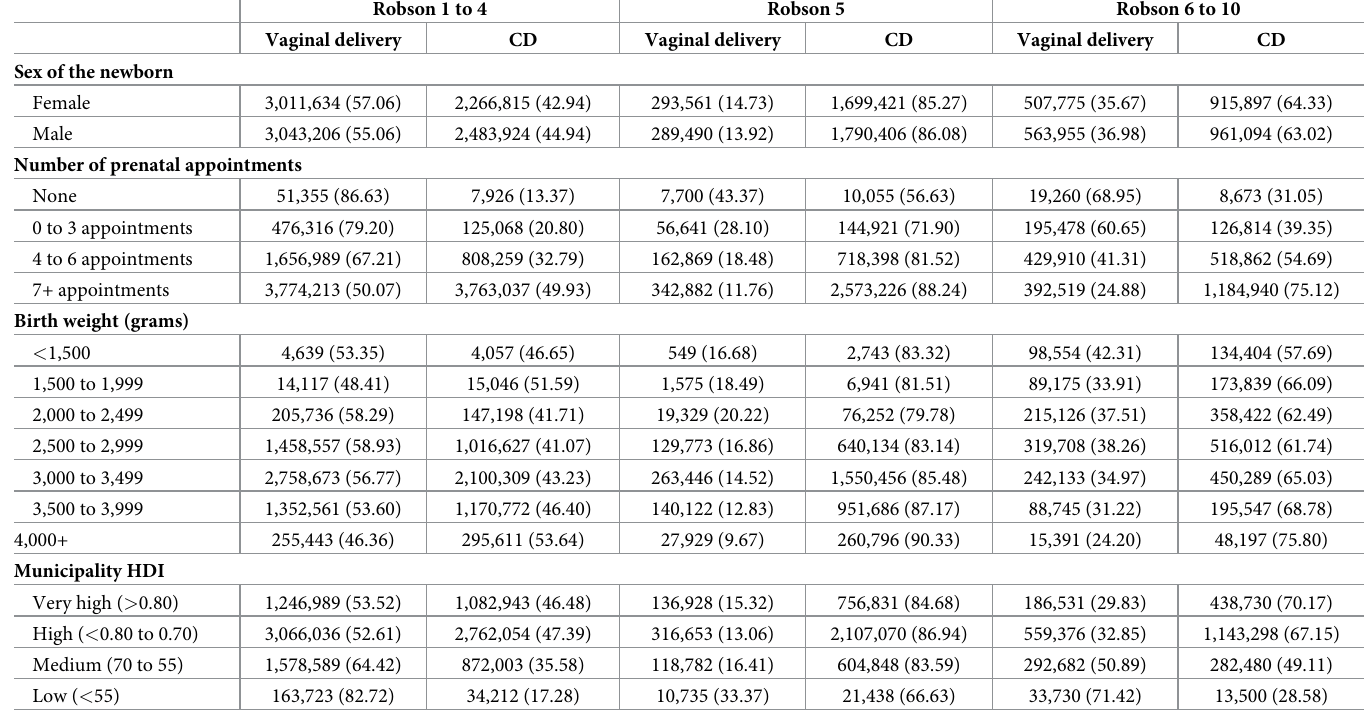
Before adjusting via PSM, singleton term babies born by unscheduled CD to nulliparous and multiparous women (2b and 4b) were more likely to die in the first 5 years of life com- pared with those born by planned CD (2a and 4a). In group 2 (nulliparas), the rates were 1.46 versus 1.18 deaths/1,000 person-years (HR = 1.22, 95% CI: 1.15 to 1.29; p < 0.001). In group 4 (multiparas), the rates were 1.99 versus 1.83 deaths/1,000 person-years (HR = 1.08, 95% CI: 1.00 to 1.17; p = 0.026). After adjusting via PSM, there was no significant difference in the mor- tality rate ratio when comparing offspring born by an unscheduled CD with those born by labor CD in group 2. In group 4, the CI were close to the null value (Table 4). In a breakdown by time period, unscheduled CD was associated with an increased mortality rate during the neonatal period (HR = 1.18, 95% CI: 1.05 to 1.32; p = 0.003) in group 2 and in the first year of life (HR = 1.15, 95% CI: 1.03 to 1.29; p = 0.010) in group 4 (Table 3). In the conditional survival analyses, we sought to understand if there was an increased mor- tality rate beyond an immediate risk that might be associated with the indication for the CD. After adjusting via PSM, for combined Robson groups 1 to 4 (excluding 2b and 4b), we found an increased death rate up to age 5 years following a CD compared with vaginal birth (HR = 1.18, 95% CI: 1.14 to 1.22; p < 0.001) for those who survived the first 7 days after birth. For those who survived the first 28 days after birth, the death rate up to age 5 years was also higher following CD (HR = 1.14, 95% CI: 1.10 to 1.19; p < 0.001). Beyond 1 year of life, the increased rate associated with CD remained for group 1 (HR = 1.18, 95% CI: 1.07 to 1.29; p < 0.001) and combined Rob- son groups 1 to 4 (HR = 1.10, 95% CI: 1.04 to 1.17; p = 0.002) (Table F in S2